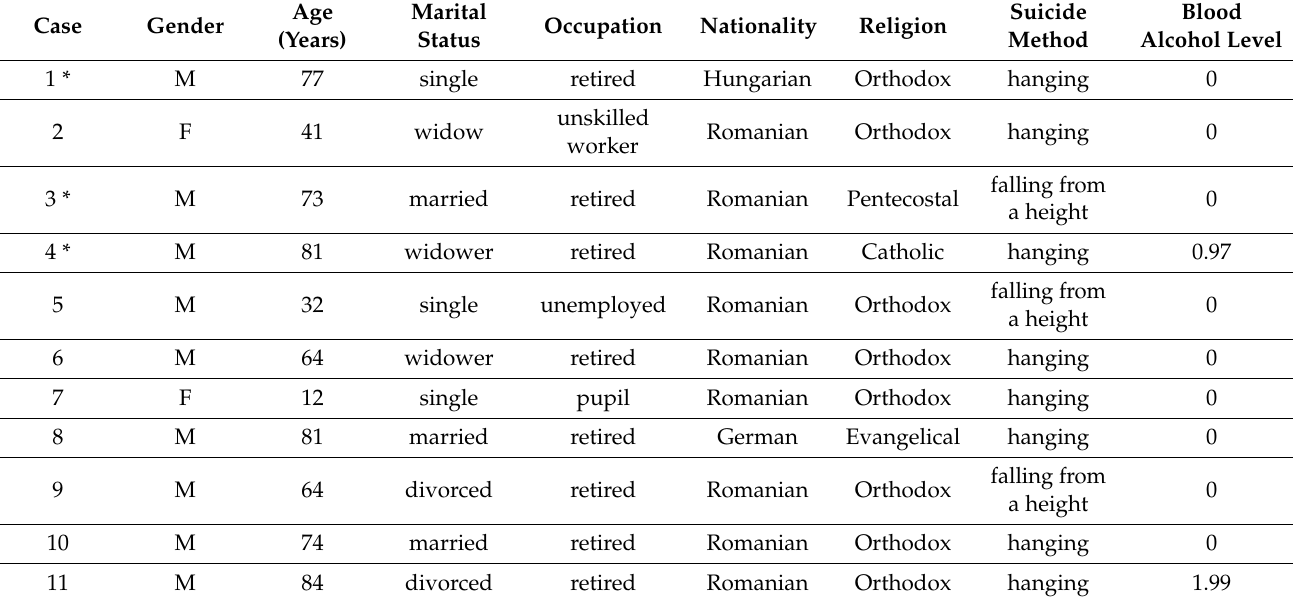
Table 1. Gender, age, marital status, occupation, nationality, religion, suicide method and blood alcohol